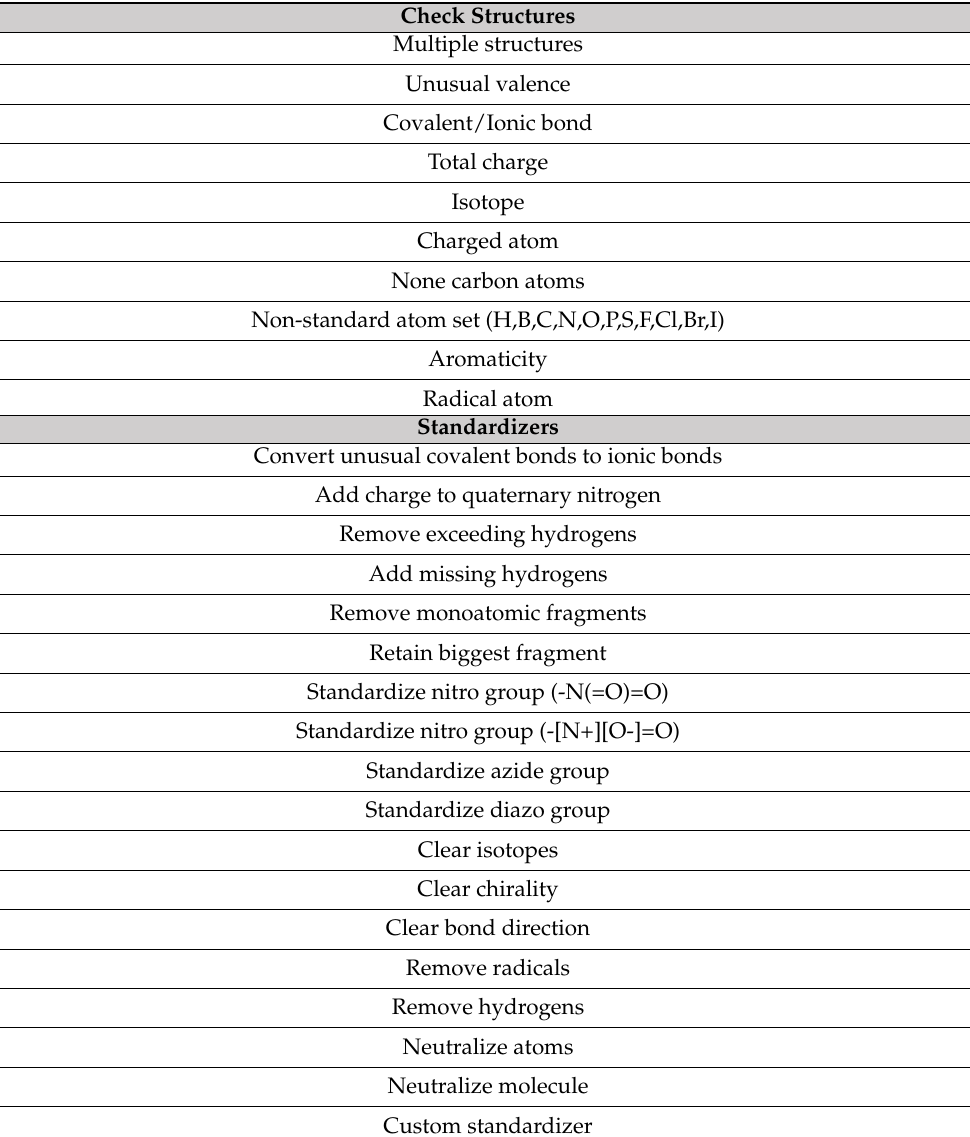
Figure 2. Same standardizers applied to the same molecule (Sodium 1,1’-biphenyl-3-olate) in a different order yield different results. “Remove monoatomic fragments” is represented with arrow A (orange) and “Convert unusual covalent bonds to ionic bonds” is represented with arrow B (blue). Table 1. List of checkers and standardizers available in alvaMolecule .